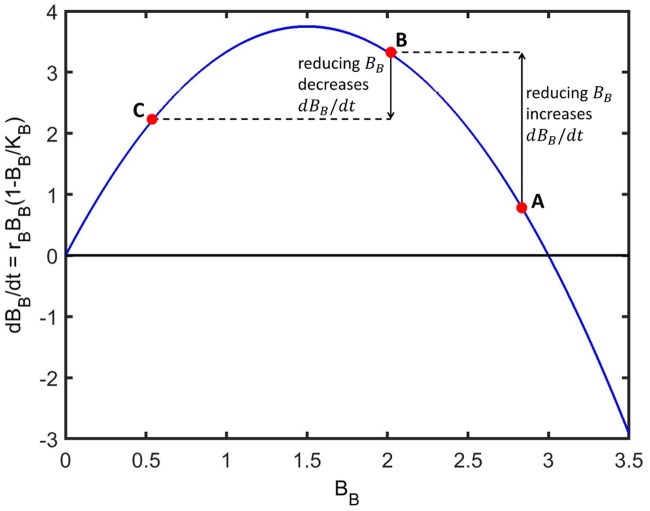
The effect of a drop in bound bacterial density upon their logistic growth rate.Treatment with inhibitor usually results in a drop in the density of bound bacteria, BB(t). The effect of this reduction in BB(t) upon the logistic growth rate, dBB/dt = rBBB(1 − BB/KB), depends upon the untreated value of BB(t), the value to which it is reduced and the carrying capacity, KB. In this example, a reduction in BB(t) from A to B results in an increase in the logistic growth rate, while a reduction from B to C results in a decrease in the logistic growth rate. Parameter choices are for demonstration purposes only.